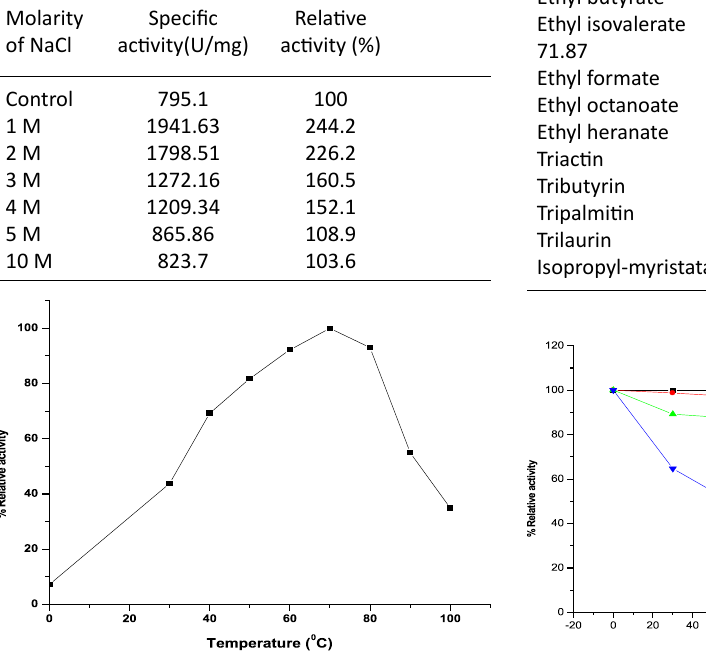
Table 4. Effect of salinity on LKE-021 esterase